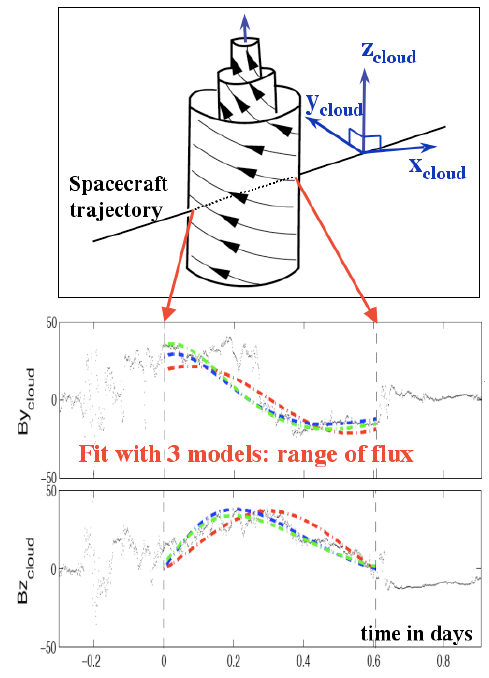
Fig. 5. Flux rope schema (top panel) and typical observed mag- netic field components of a MC when rotated in the cloud frame (dots in the two lower panels). ˆ z cloud is along the cloud axis, ˆ y cloud is orthogonal to both the MC axis and the spacecraft trajectory, and ˆ x cloud completes the right-hand orthogonal base. The observed magnetic field in MCs usually has the characteristics of a flux rope. The signatures are a coherent reversal of By cloud ( ≈ azimuthal com- ponent), a peaked Bz cloud (axial component), and a small Bx cloud (not shown since it is globally constant and weak, due to a low im- pact parameter). The blue, green and red dashed curves are the fit using three flux-rope models (Mandrini et al.,